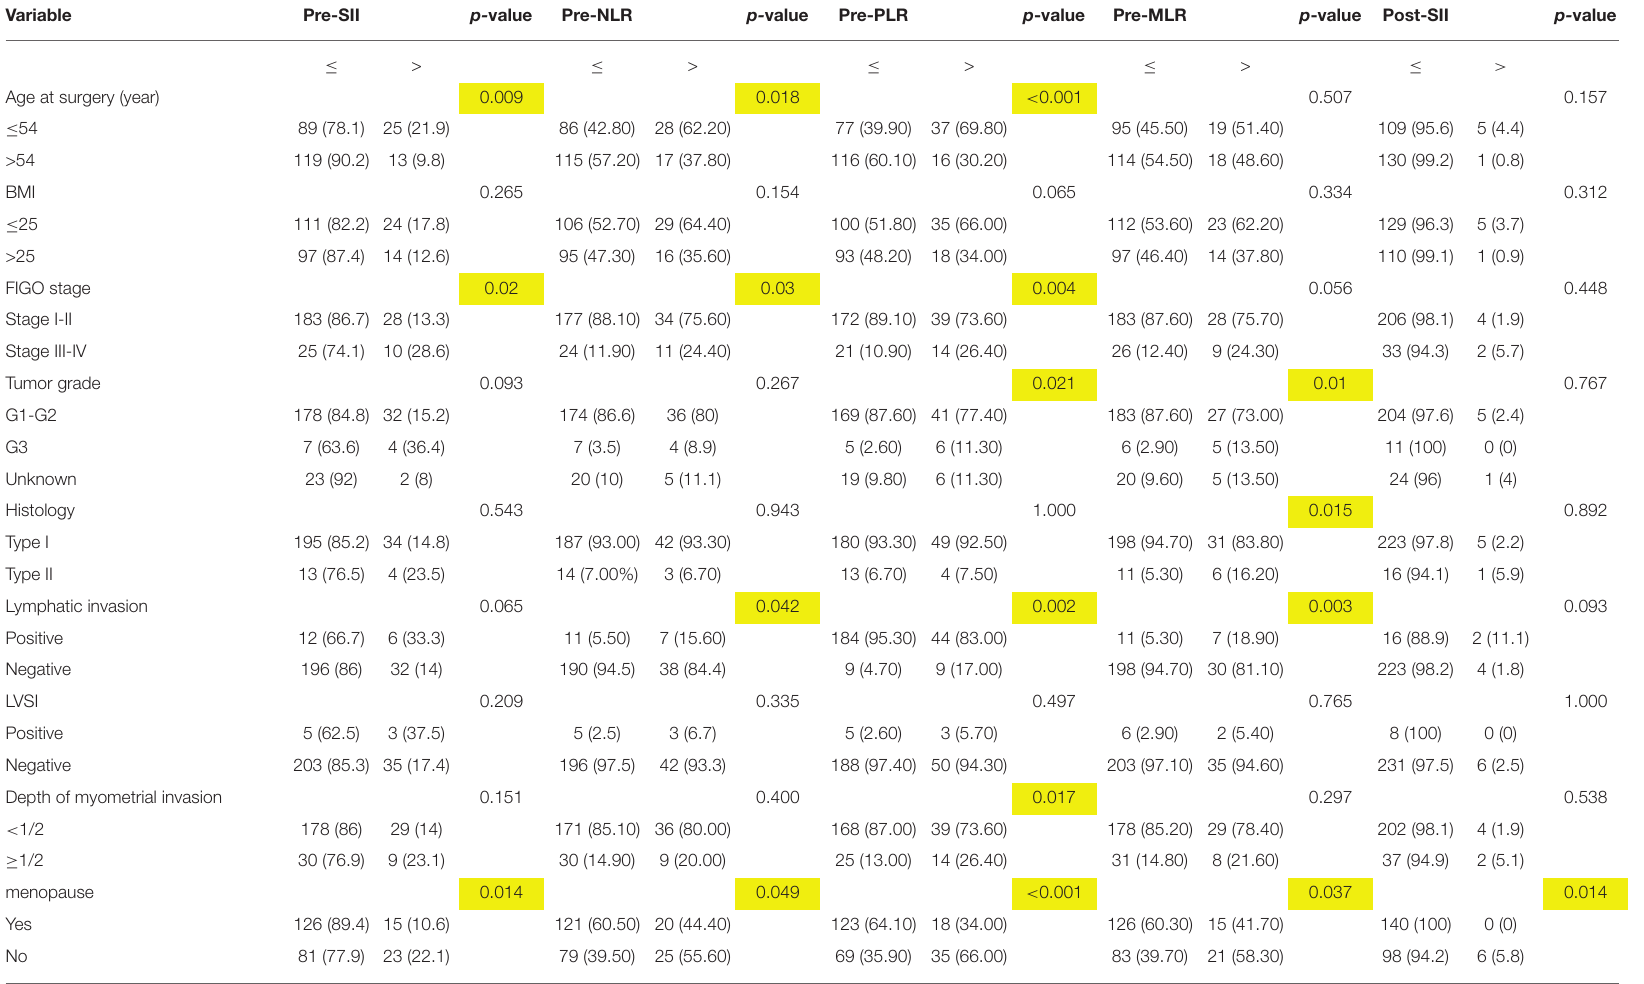
TABLE 2 | Correlations between the preoperative SII, NLR, PLR, MLR, postoperative SII, and clinicopathological variables in patients with endometrial